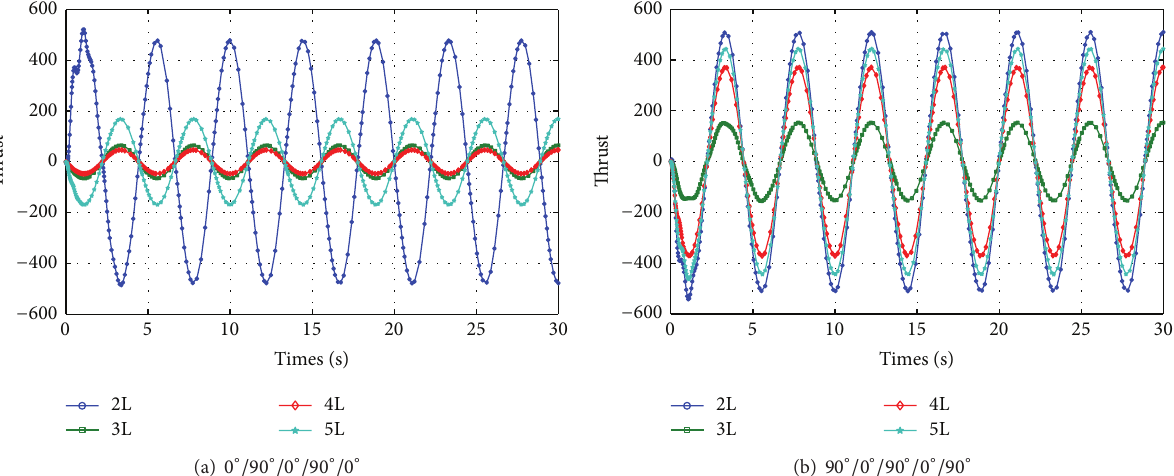
Figure 5: Thrust of fin in the case of translation motion.